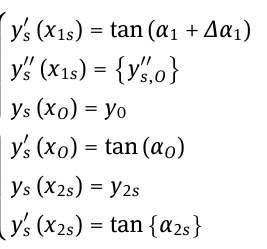
profile thickness ∆rφ (Fig. 4b):